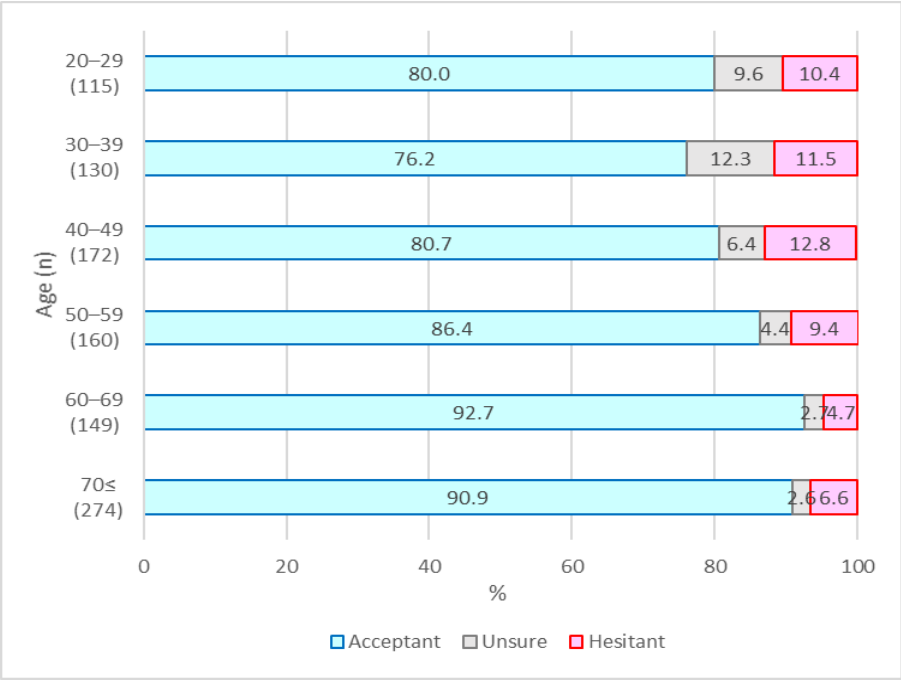
Figure 2. Vaccination attitude by age group in September 2021. The frequency of health-related behavior and the scores of COVID-19-related psy- Table 3. Health-related behavior, COVID-19-related psychological variables, and vaccination atti- tude in September 2021. chological variables are listed in Table 3. Those who accepted the vaccine had a higher frequency of influenza vaccination (median: 4.0) and medical checkups (median: